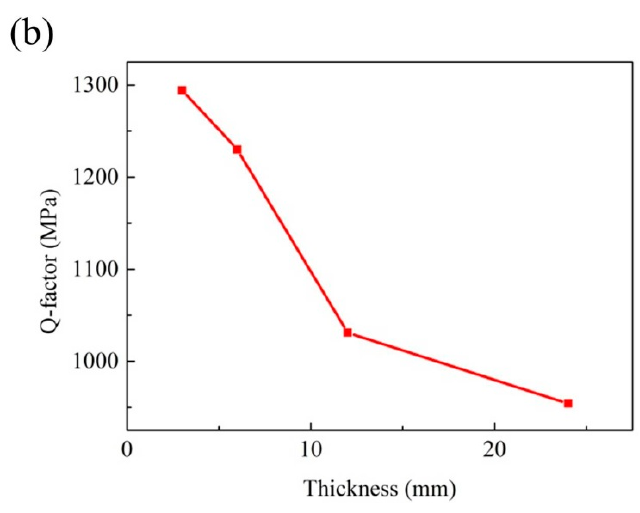
Figure 11. The tensile properties of the superalloy casting ( a ) tensile properties; and ( b ) Q-factor. The quality index (Q) is taken to be more descriptive of the true tensile properties of casting than either the ultimate tensile strength (UTS) or the elongation (El) alone. Q is defined as a semi-logarithmic plot of UTS verse El to fracture and it is expressed as follows: